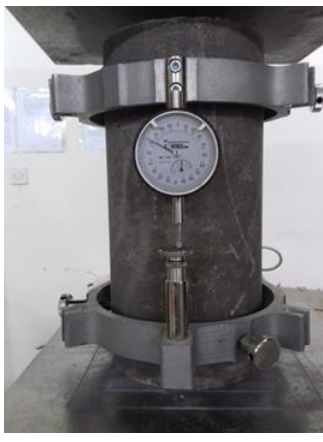
Figure 5. Measurement of the modulus of elasticity of SCC